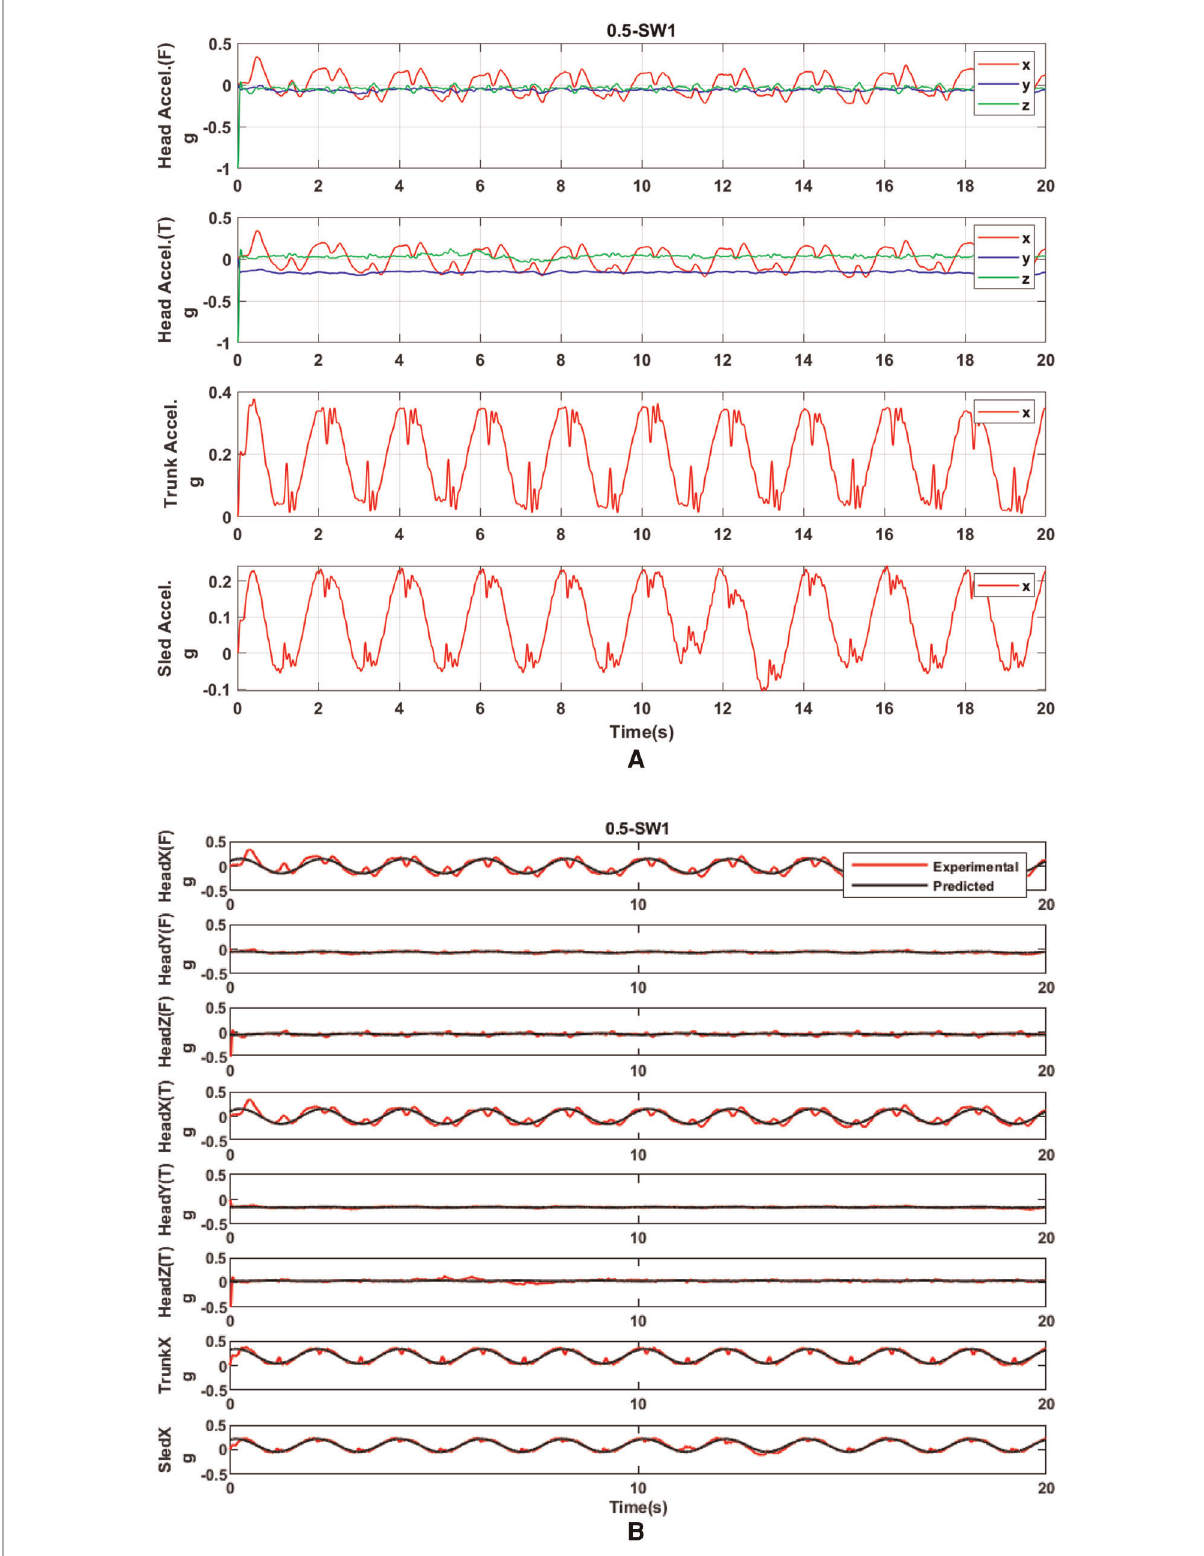
FIGURE 7 ( A ) Rawaccelerationofthe head, trunk, and sledwith SWat 0.5 Hz. ( B ) Accelerationprocessed by the fi tted-sine model withSWat0.5 Hz.Tand FonY-axis labels mean the acceleration measured at the frontal part of the head and the acceleration measured at the temporal part of the head,